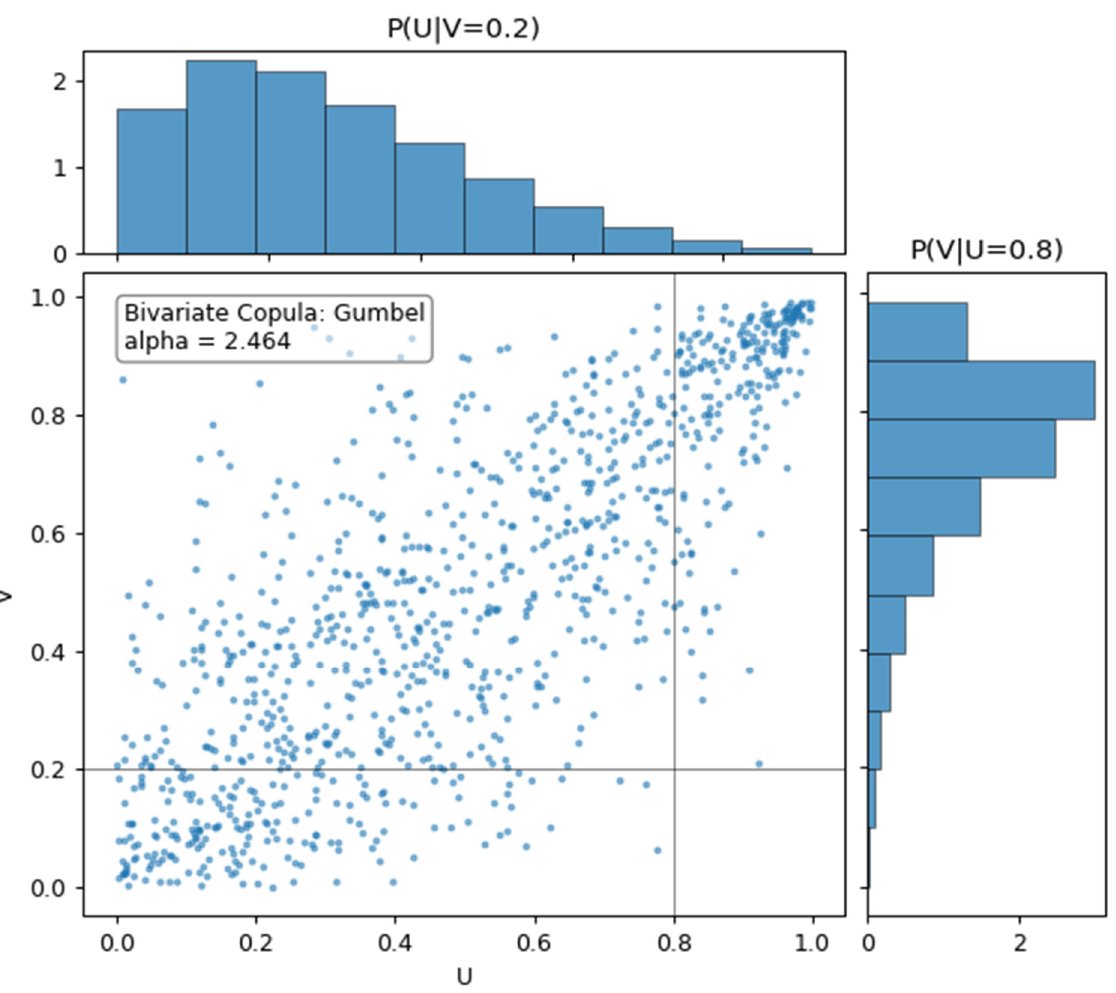
Figure 4. Bivariate Gumbel copula fitted to the {U: USDZAR, V: GBPZAR} variable pair and an example of the histograms of the conditional distributions.